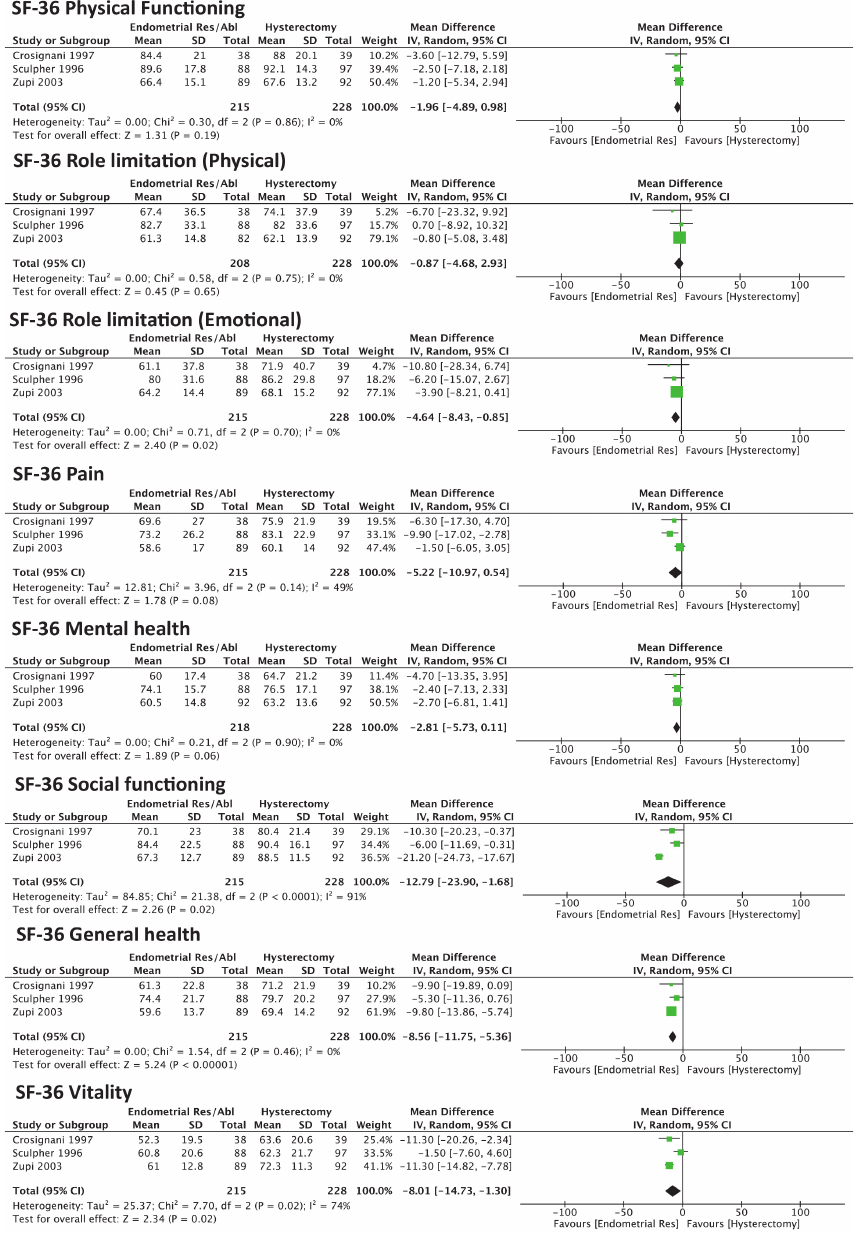
Figure 3. Forest plot for the primary outcome (QoL) evaluated using SF-36